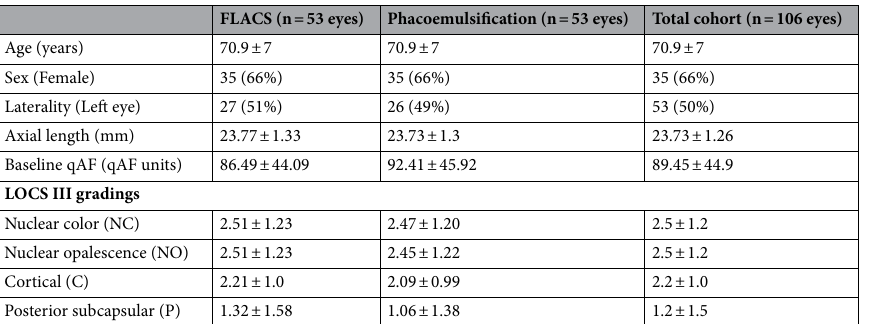
Table 1. Demographic data of eyes randomized into each treatment arm and for the total cohort. Data are means ± standard deviations or numbers (%). FLACS femtosecond-laser assisted cataract surgery, LOCS Lens Opacities Classification System, qAF quantitative